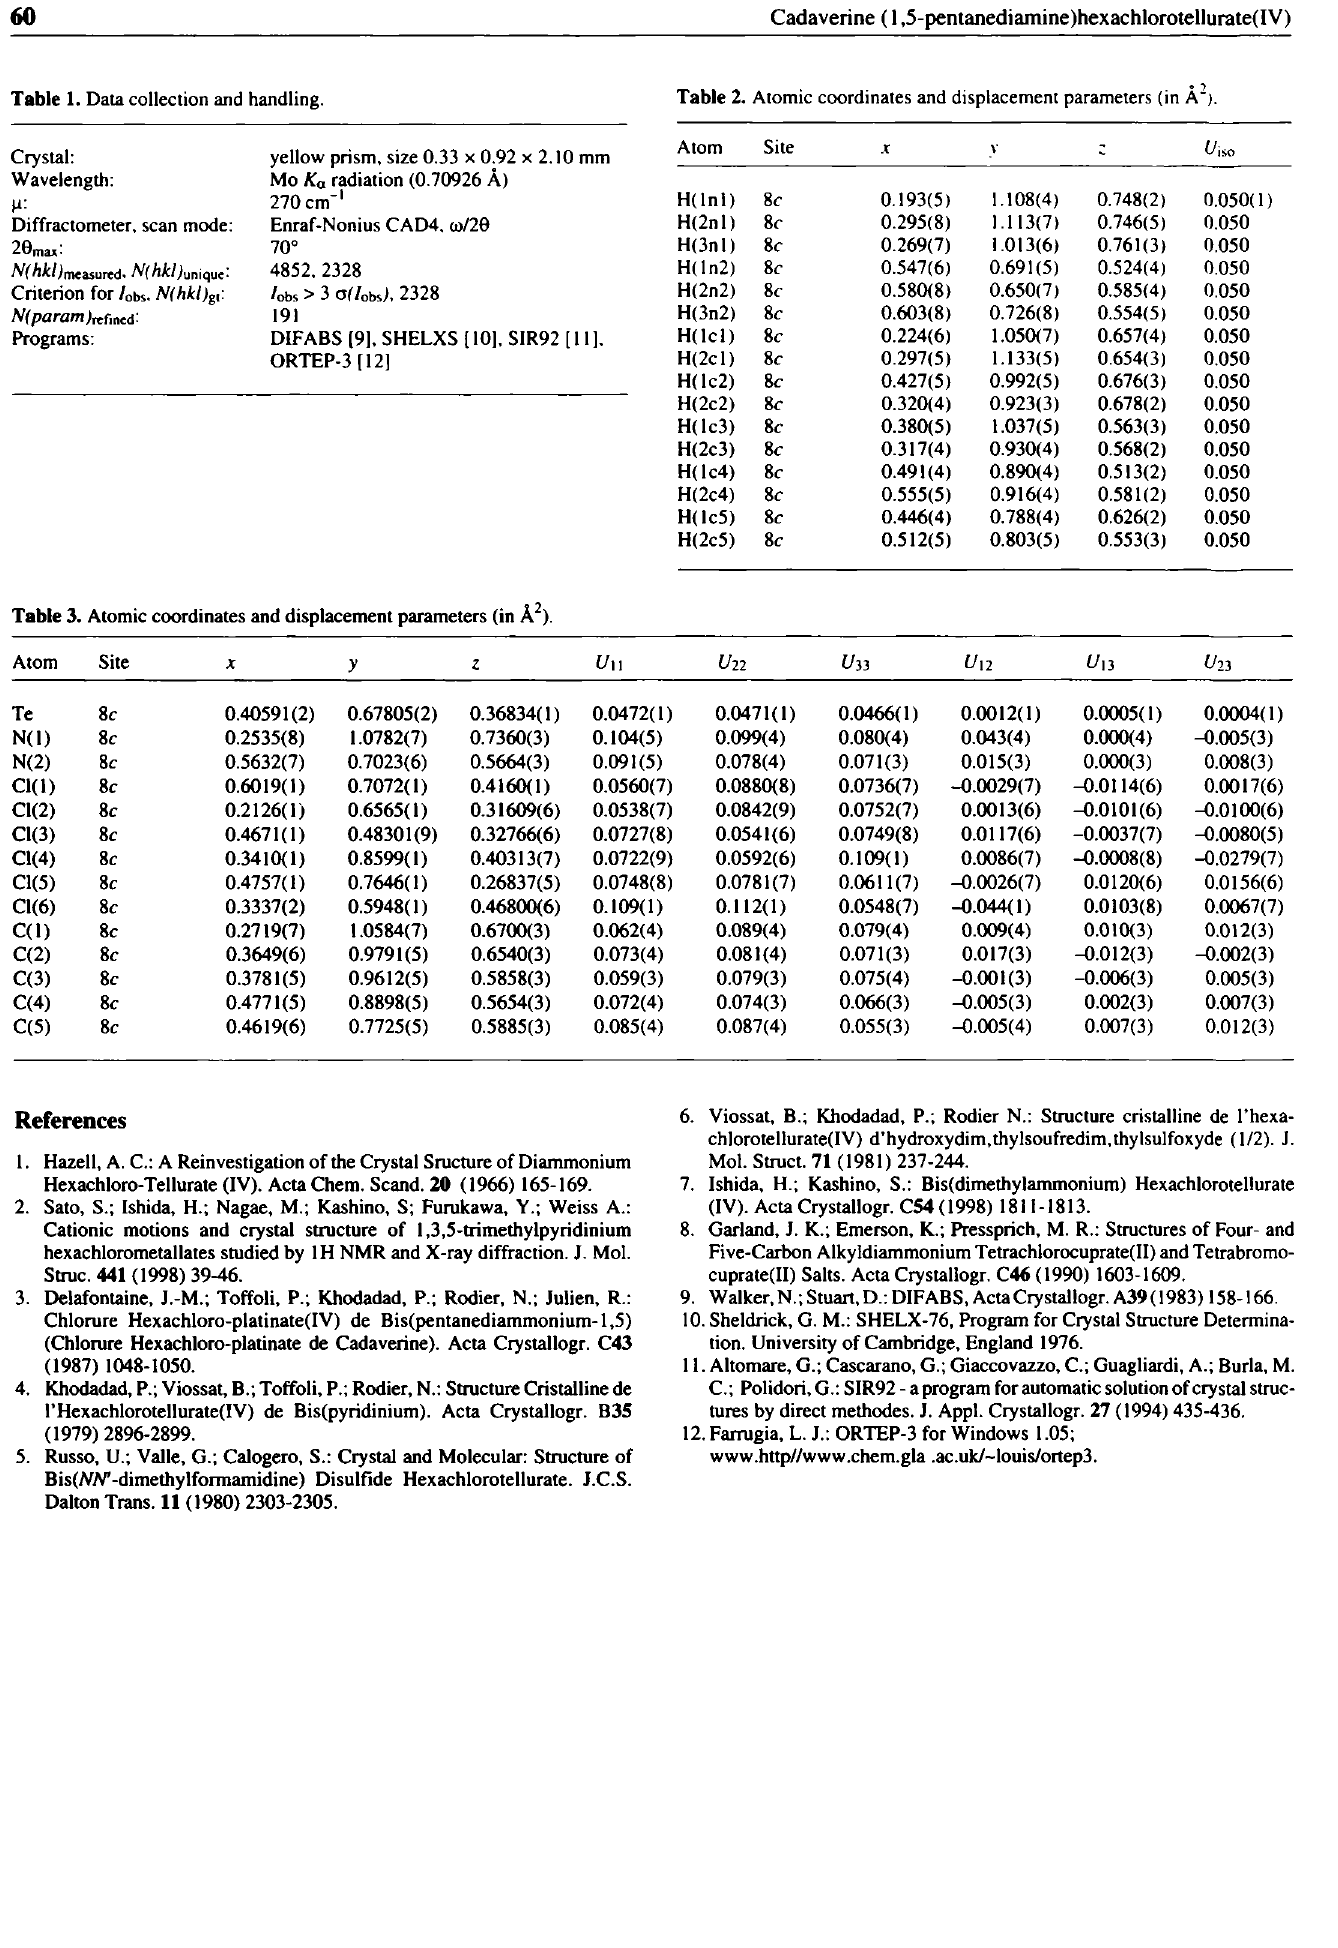
Table 1. Data collection and handling. Table 2. Atomic coordinates and displacement parameters (in A").